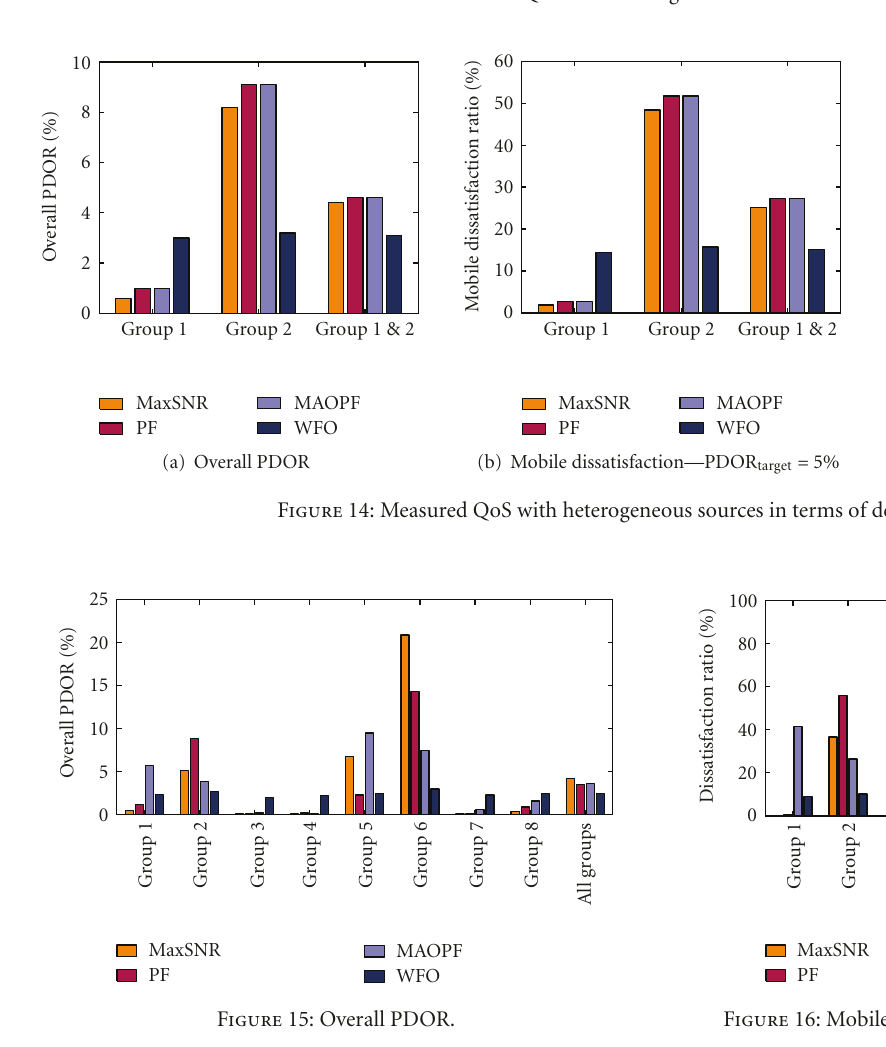
Figure 13: Measured QoS with heterogeneous sources in terms of bit rate.